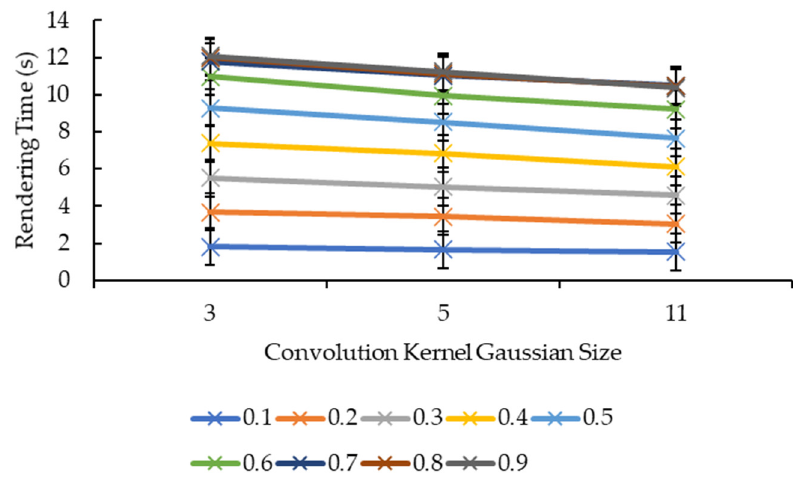
Figure 13. Graph of rendering time against convolution kernel size for convolution kernel Gaussian.